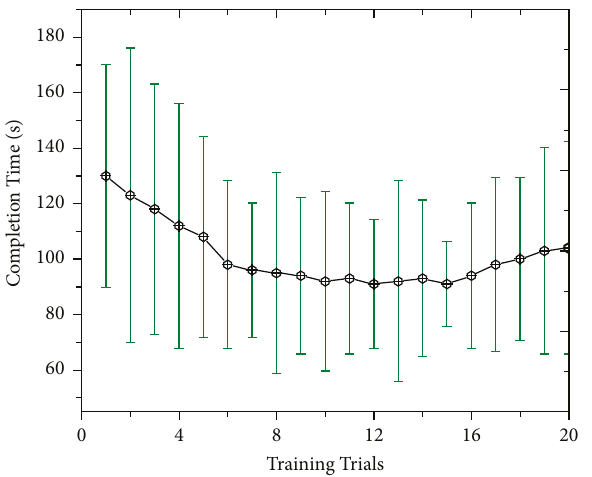
Figure 8: Completion time as a function of training trials.